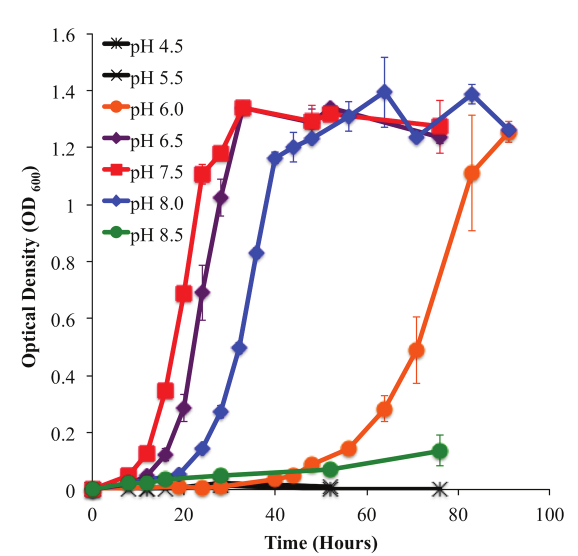
Figure 3. Growth Curve of NRC-1 cultures grown under acidic and alkaline conditions. Growth of Halobacterium sp. NRC-1 at pH 4.2 (black ×s), pH 5.2 (light green circles), pH 6.2 (light blue diamonds), pH 7.2 (red squares), pH 8.2 (blue diamonds), and pH 9.2 (green circles). Values for the symbols are the average of all replicates and the error bars represent the standard deviation at each time